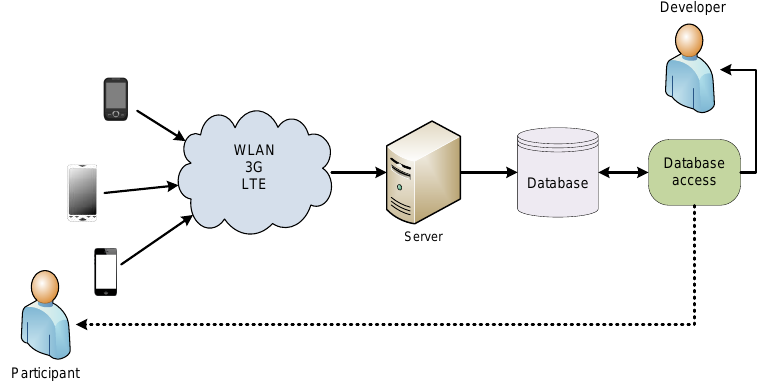
Figure 1. Pilot system architecture. Smartphones send sensor data over one of the available wireless interfaces to the processing computer (server). Processing results are stored in the database. They can be analysed and retrieved through a database access